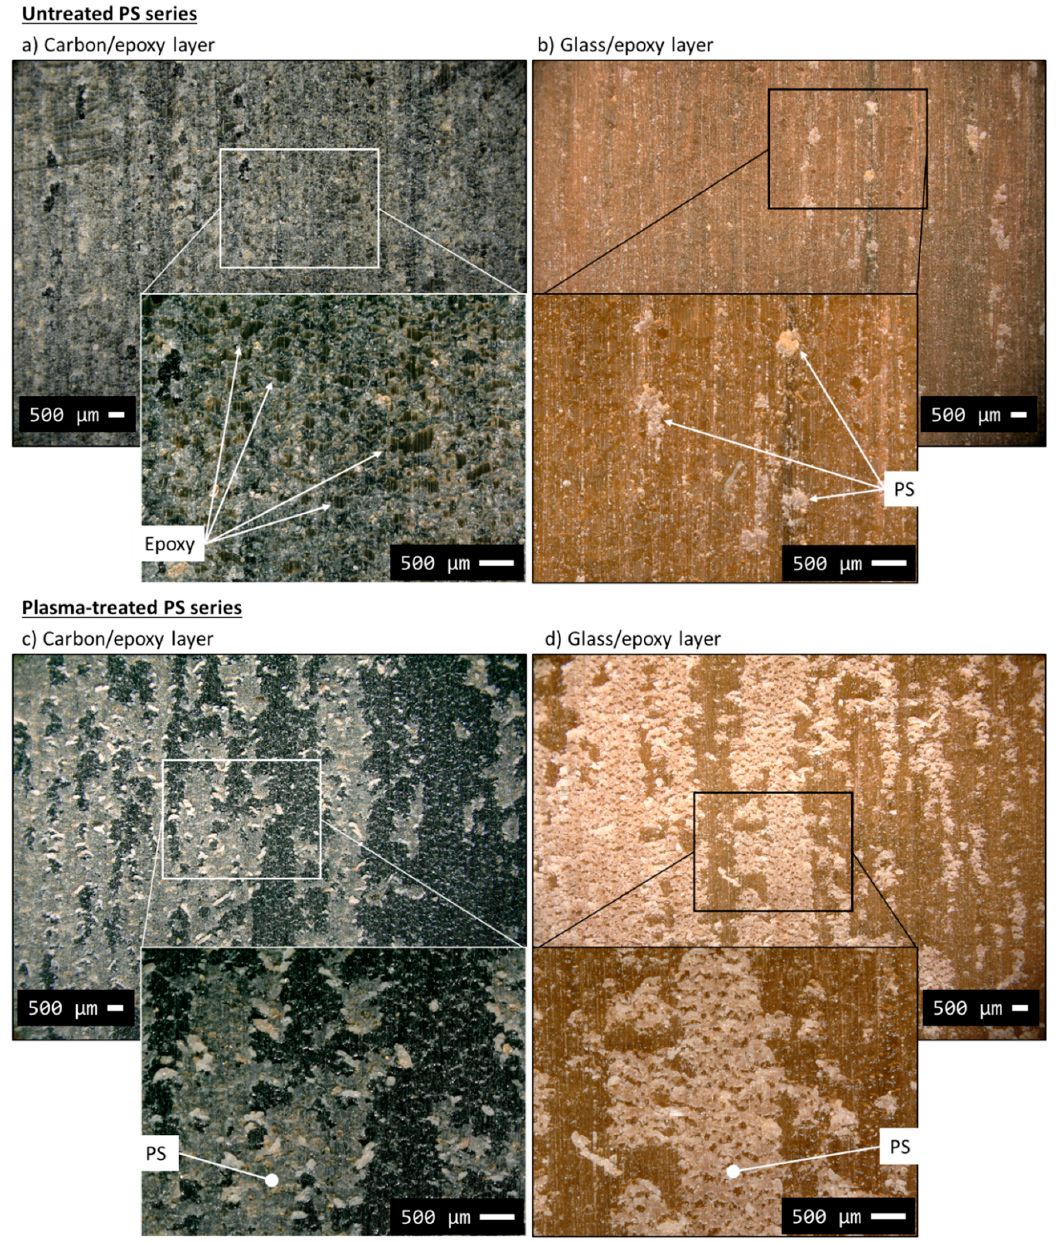
Figure 12. Delaminated surfaces of typical samples from the PS (( a ), ( b )) and plasma-PS (( c ), ( d )) series analysed with digital microscope.